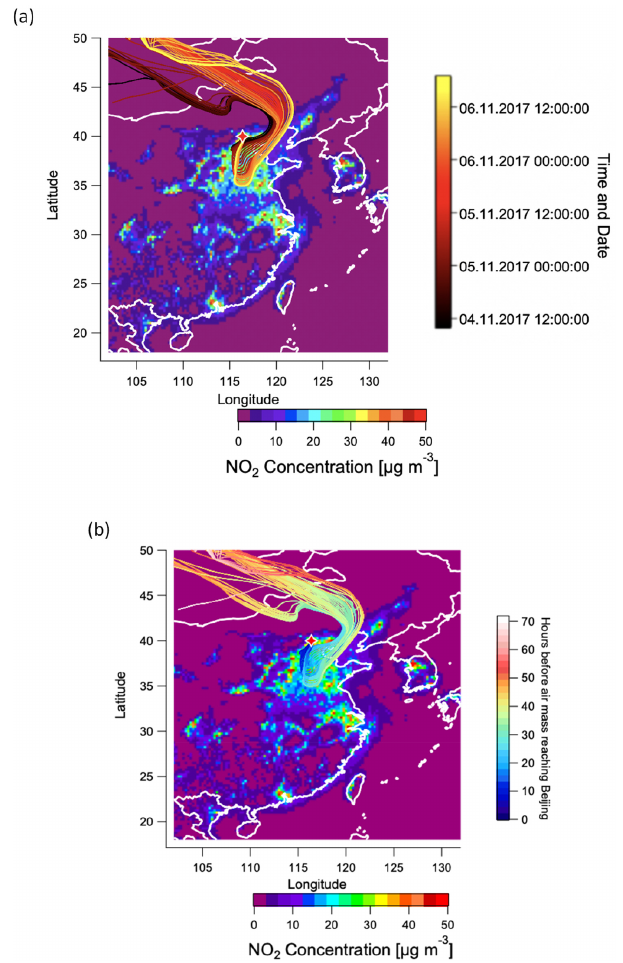
Figure 12. Air mass trajectory analysis. (a) 72h back-trajectories (HYSPLIT) for the haze event from 4 to 7 November, colour-coded by date and time, (b) 72h back-trajectories for the haze event from 4 to 7 November, colour-coded by hours before the air mass reaches Beijing. In both figures, trajectories are overlaid on a 2015 map of surface NO 2 concentrations based on the CHIMERE model and driven by the 2015 DECSO inventory (Liu et al.,